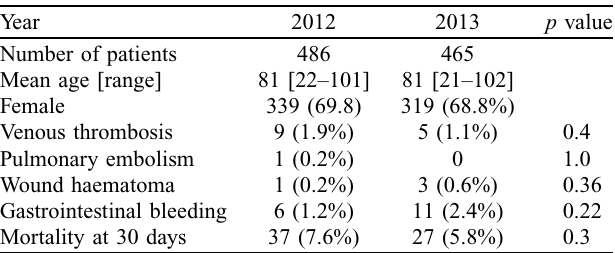
Table 2 details the number of thromboembolic and